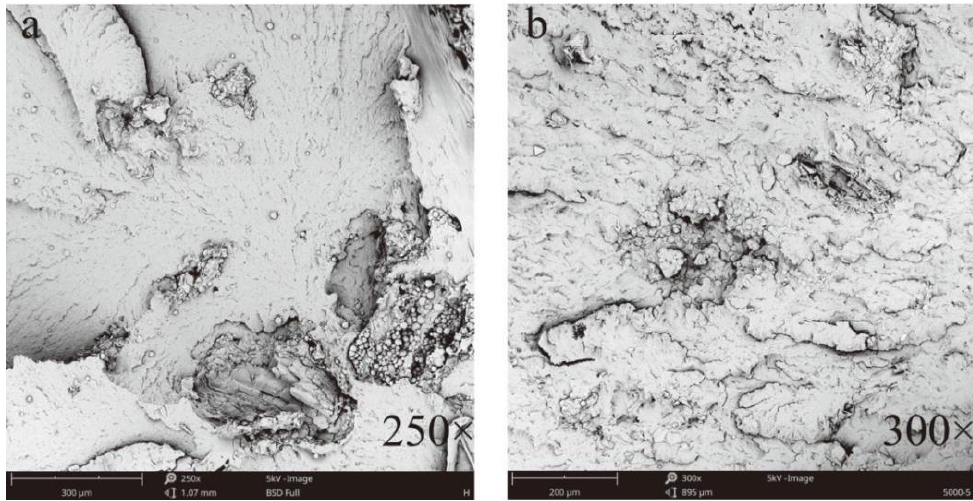
Figure 6. Tensile fracture surfaces of composite ( a ) before MDI modification and ( b ) after MDI modification.